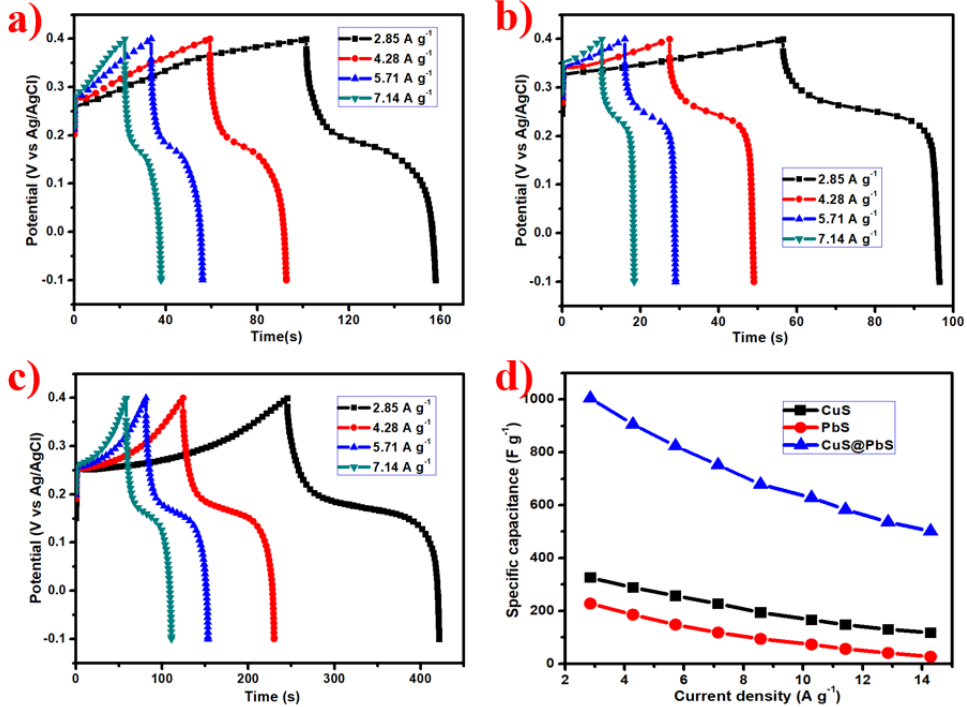
Figure 6. Charge and discharge curves of the ( a ) CuS, ( b ) PbS and ( c ) CuS@PbS composite electrodes at different current densities of 2.85, 4.28, 5.71 and 7.14 A g − 1 in 3 M KOH solution; ( d ) specific capacitance as a function of current density.